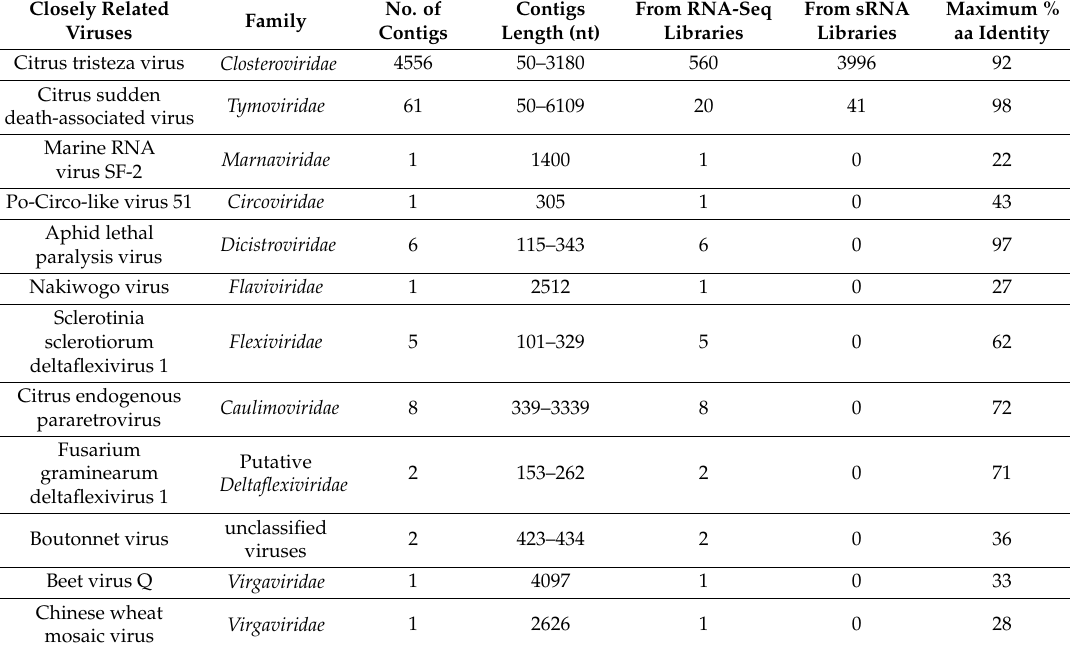
Table 3. Contig counts and contig length for each viral species (>300 nt in length) identified in the BLASTx analysis of the total data